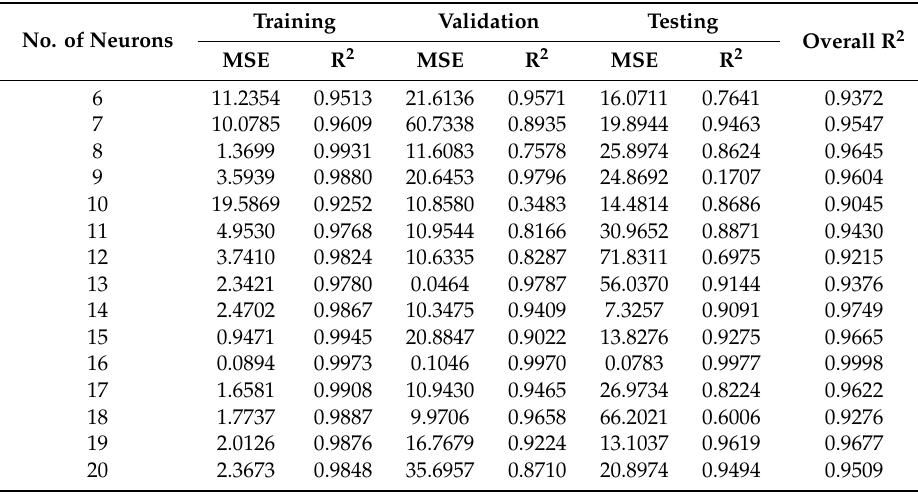
Table 2. Values of Training, Testing, Validation and overall R 2 based on number of